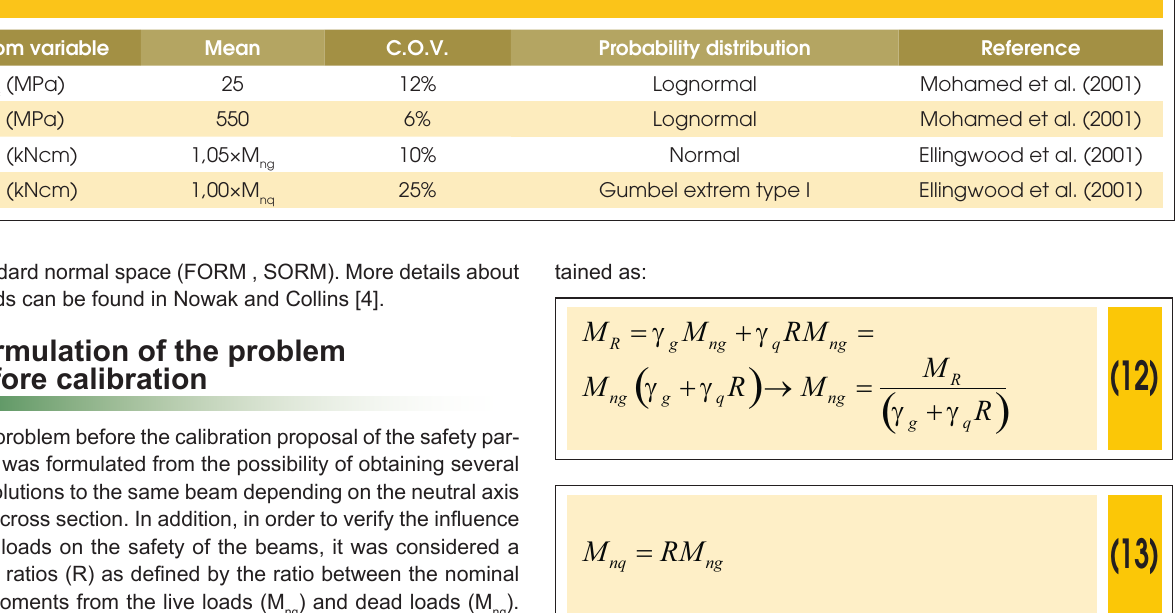
Table 1 – The adopted random variables on the